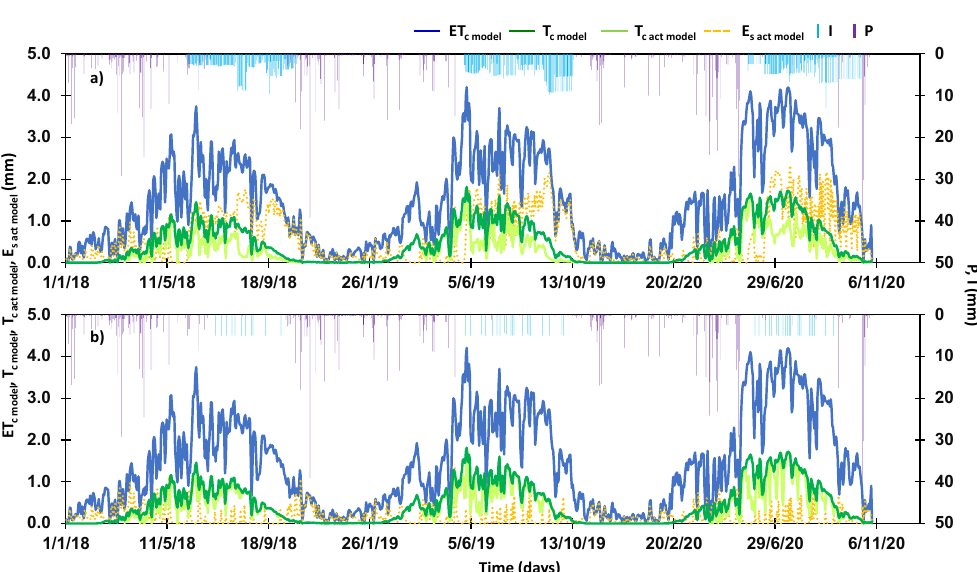
Figure 5. Crop evapotranspiration (ET c ), potential (T c model ) and actual (T c act model ) crop transpiration, actual soil evaporation (E s act model ), irrigation (I), and precipitation (P) fluxes following ( a ) irrigation applied by the farmer and ( b ) an optimized irrigation schedule computed by the model (the subscript model corresponds to results computed with the MOHID-Land model).